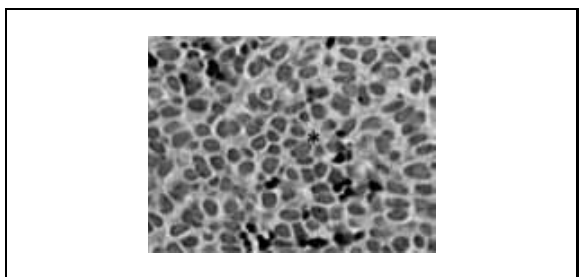
Figura 1 – Neoplasia sólida, constituída por células pequenas, com escasso citoplasma, núcleo hipercromático e nucléolo inconspícuo. Presença de pseudorroseta (*) (HE